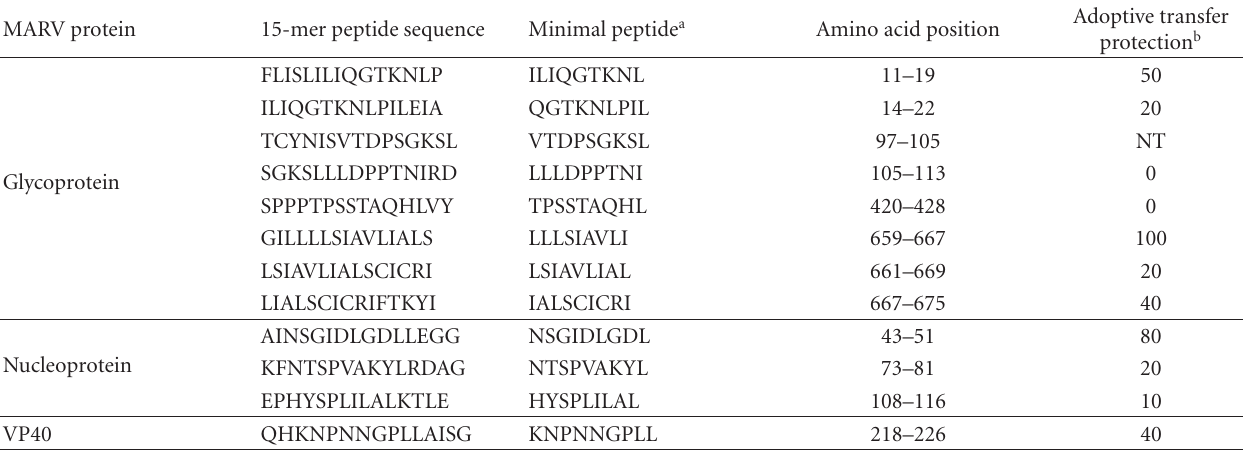
a 9 mer peptide sequence derived from HLA binding predictions. b Percentage of animals protected from lethal challenge with mouse-adapted Marburg virus after adoptive transfer of CD8 lymphocytes specific for the 9-mer peptide sequences. NT: not